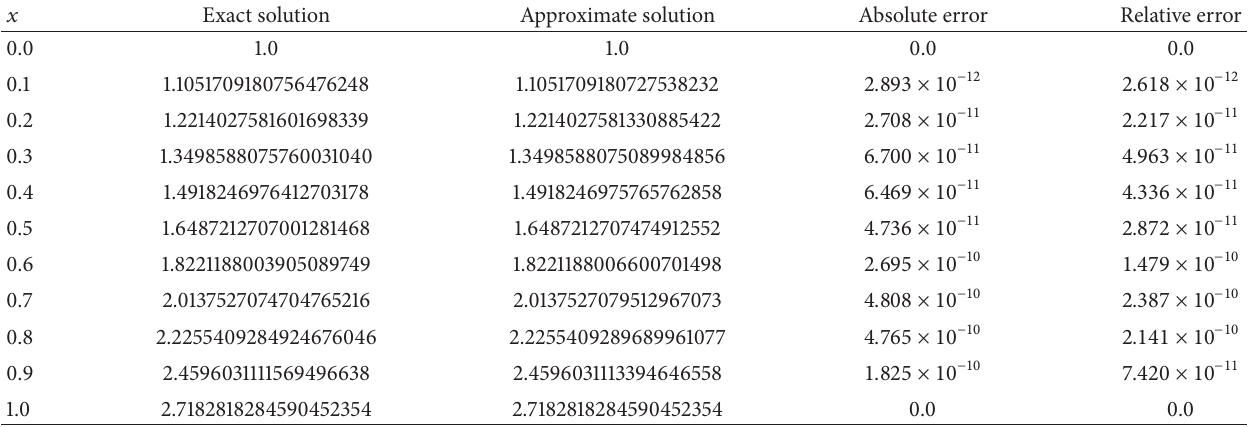
Table 1: Numerical results for Example 10 (time (s): 1.645).